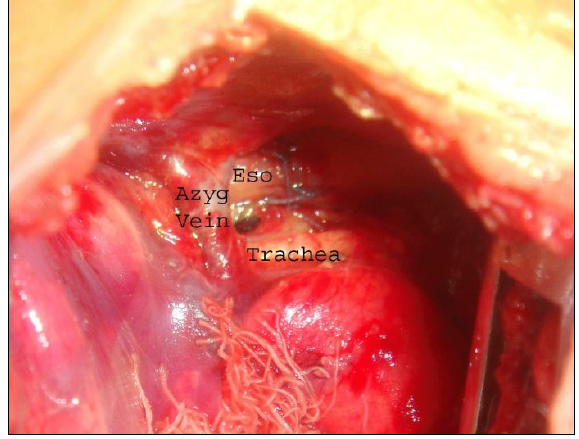
Fig. 3: Anastomosis completed with the neo- esophagus lying medial to the preserved